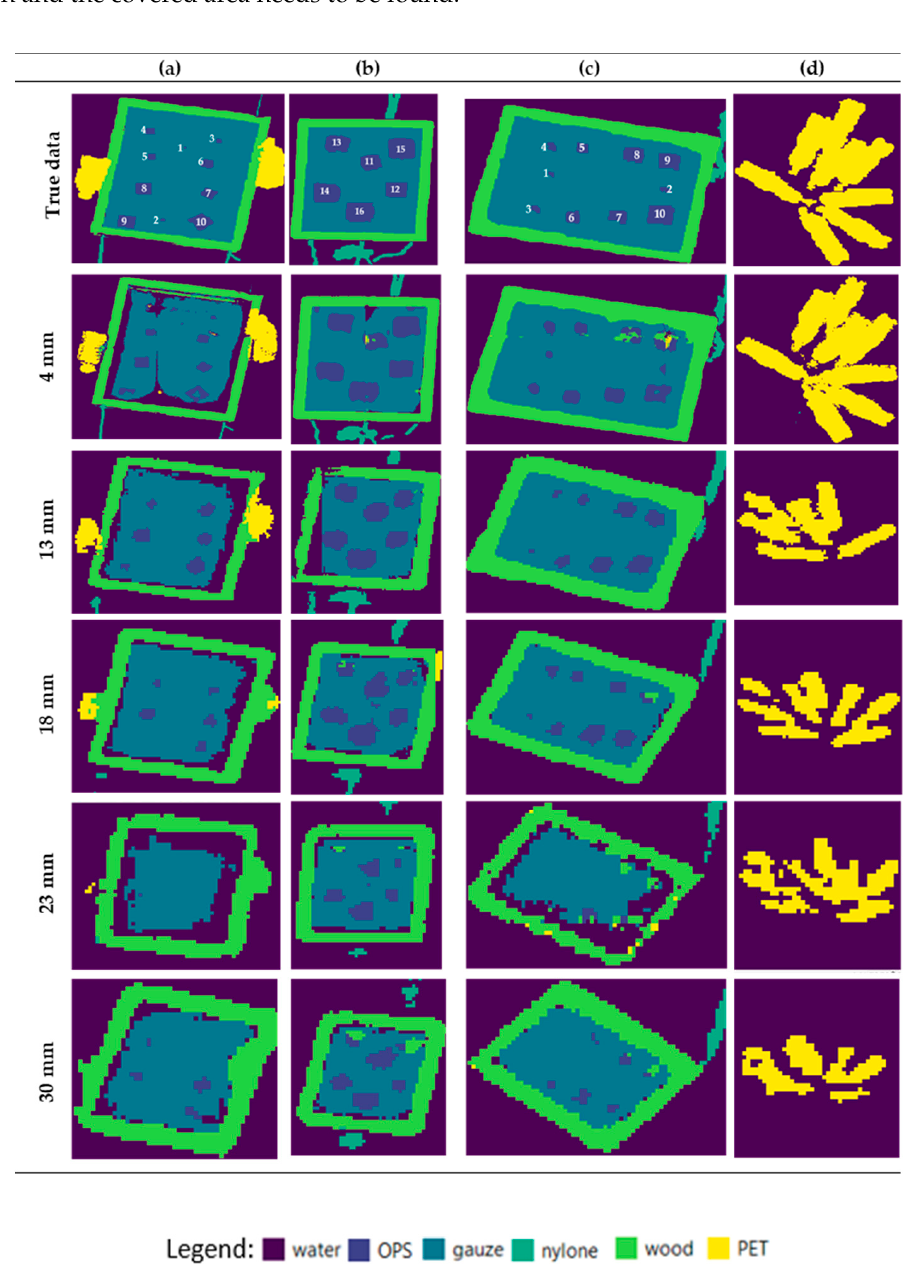
Figure 7. Ground truth data and results of the classification using the ResUNet50 algorithm for visual comparison, at different spatial resolutions and for different plastic materials , located underwater ( a ) and overwater ( b , c , d ) (Dataset 2).